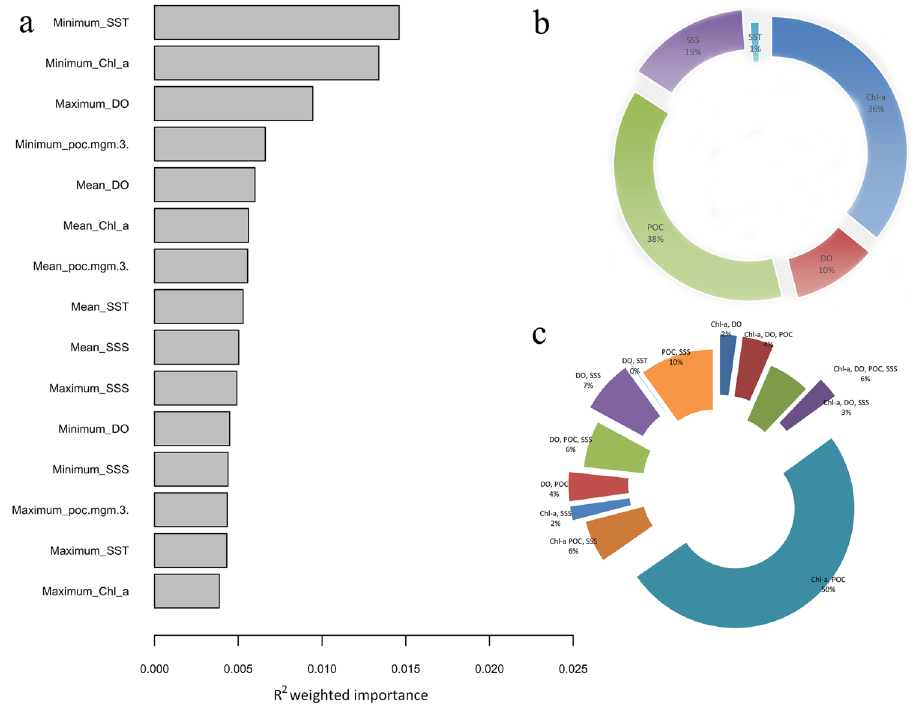
Figure 4. ( a ) The contribution of each environmental variable in explaining genetic variation across S. longiceps populations generated from gradient forest analysis. ( b ) The percentage of loci associated with chlorophyll- a concentration (Chl- a ), particulate organic carbon concentration (POC), dissolved oxygen concentration (DO), sea surface salinity (SSS), and sea surface temperature (SST) identified by LFMM analyses and ( c ) their overlaps. The plot was generated with LFMM in LEA 48